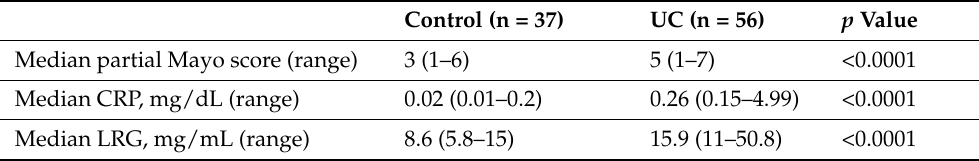
Table 3. Comparison of each value of partial Mayo score, C-reactive protein (CRP), and leucine-rich α 2 glycoprotein (LRG) between the control patients with normal colonoscopic findings and those with ulcerative colitis other than proctitis.